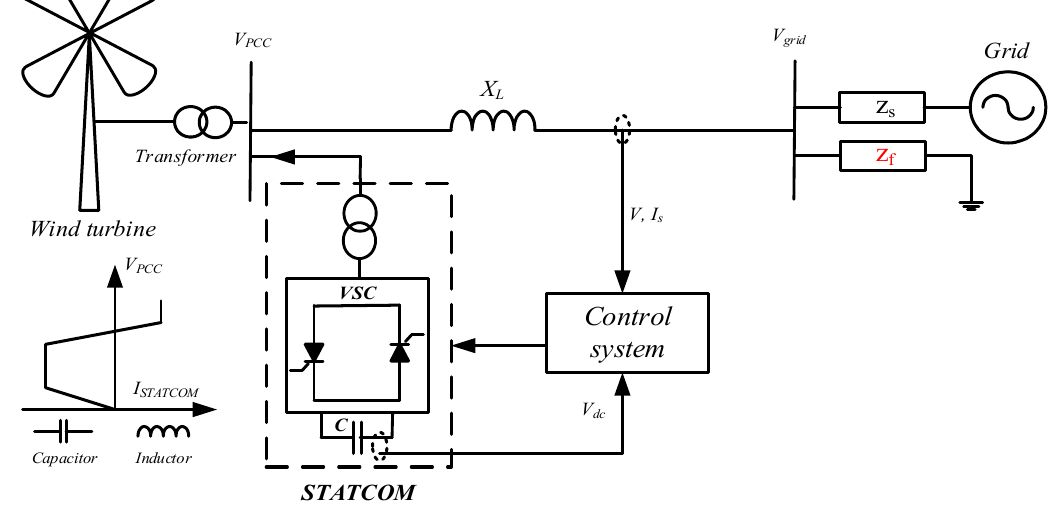
Figure 4. The structure of the WT based FSIG connected to STATCOM.